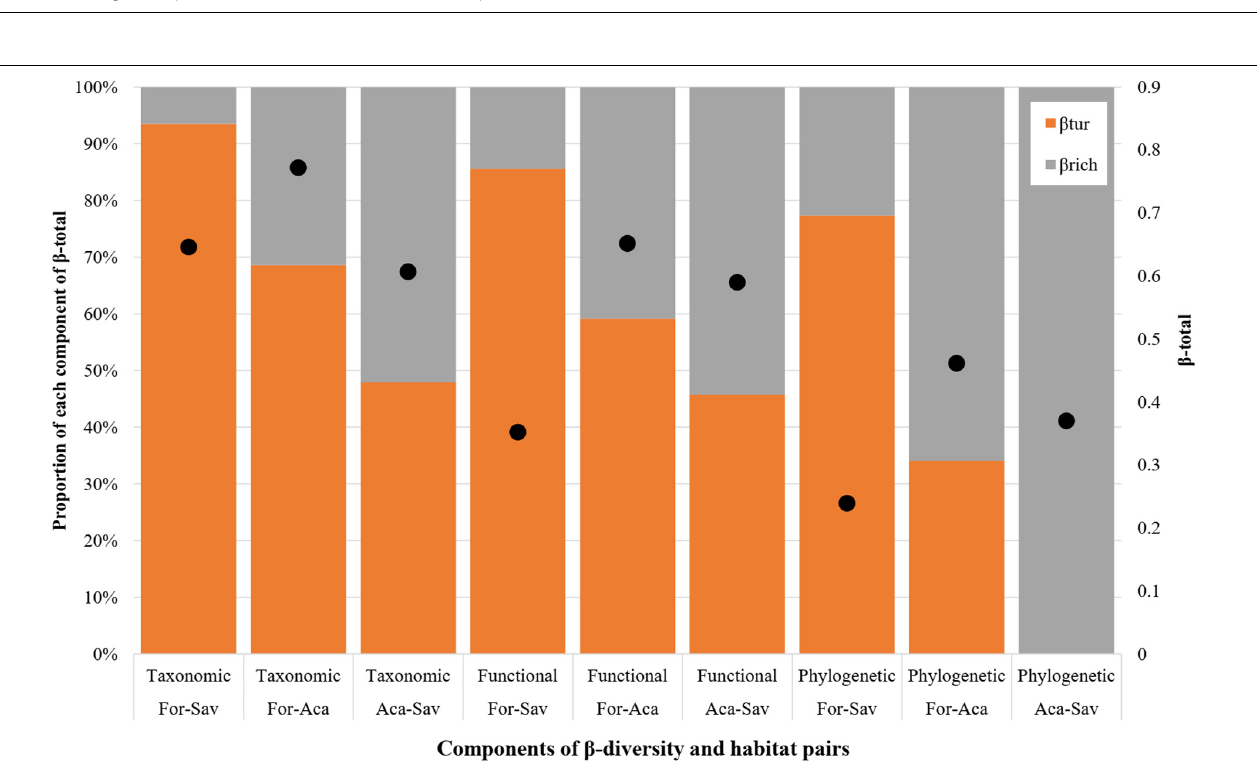
FIGURE 5 | Values of taxonomic (T β D), functional (F β D), and phylogenetic (P β D) β -diversity and percentage of each of the components ( β Tur and β Rich ) that make up the total β -diversity for the bat assemblages sampled in the forest, savannah and acacia plantations in an Amazonian savannah in the northern Brazilian Amazonia in 2017. The black dots inside the bars represent the total β -diversity values of each partition ( z -axis). For, Forest; Sav, Savannah; Aca, Acacia.